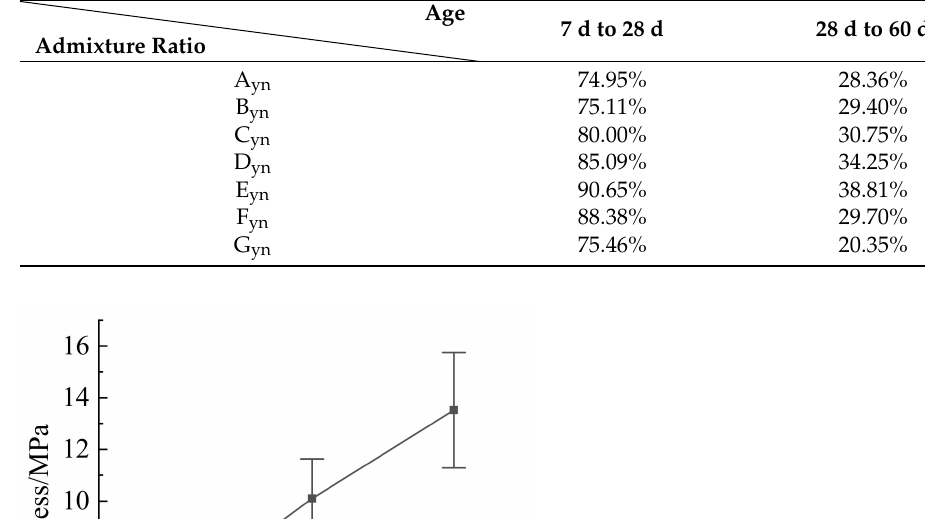
Figure 3. Dynamic Stress-age Relationship of Ni-Fe Slag Powder Soil Cement. Table 6. Growth Rate of Peak Dynamic Stress with Age for Nickel-Iron Slag Powder Soil Cement.